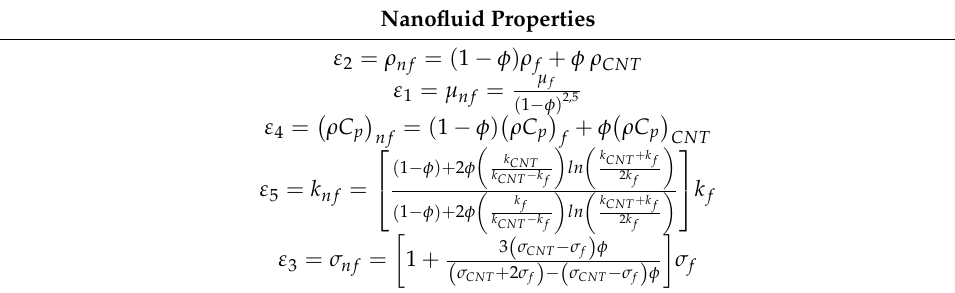
Table 1. Proposed nanofluid models. Khan et al. [18], Xue [35].